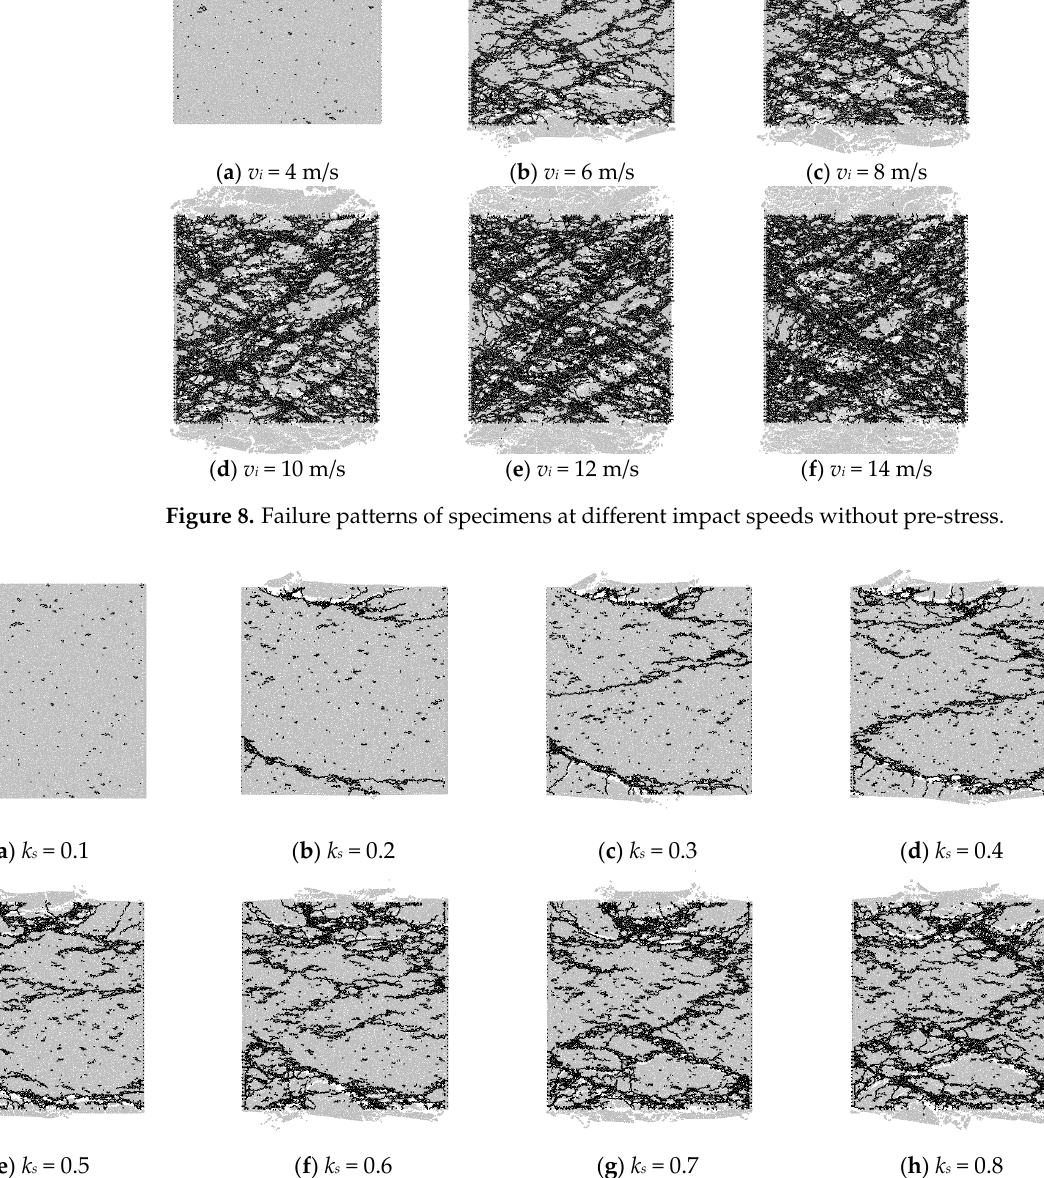
( h ) k s = 0.8 Figure 10. Failure mode of sample subject to different pre-stress levels at 8 m/s impact speed.